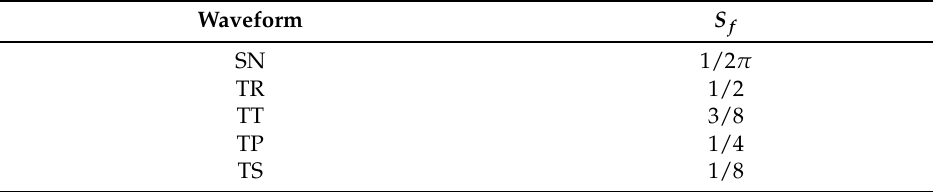
Figure 6. Slope measurement via oscilloscope. Table 1. Slope